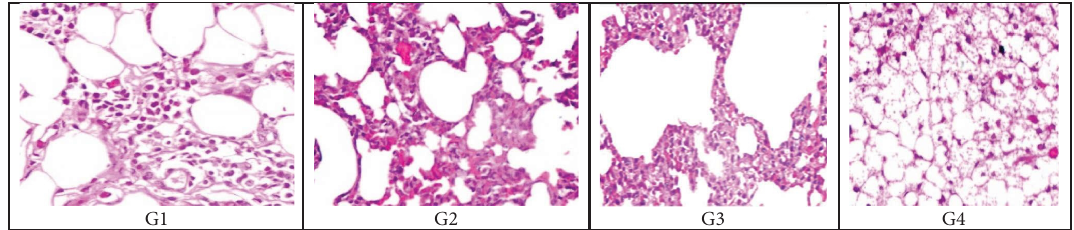
Figure 8: H&E stain showing the histological structure of the lung tissue section at 20x magnifcation in the form of (G1) negative control group, (G2) rats infected with MRSA without treatment, (G3) rats treated with antibiotics and (G4) rats treated with A. herb Alba TiO2